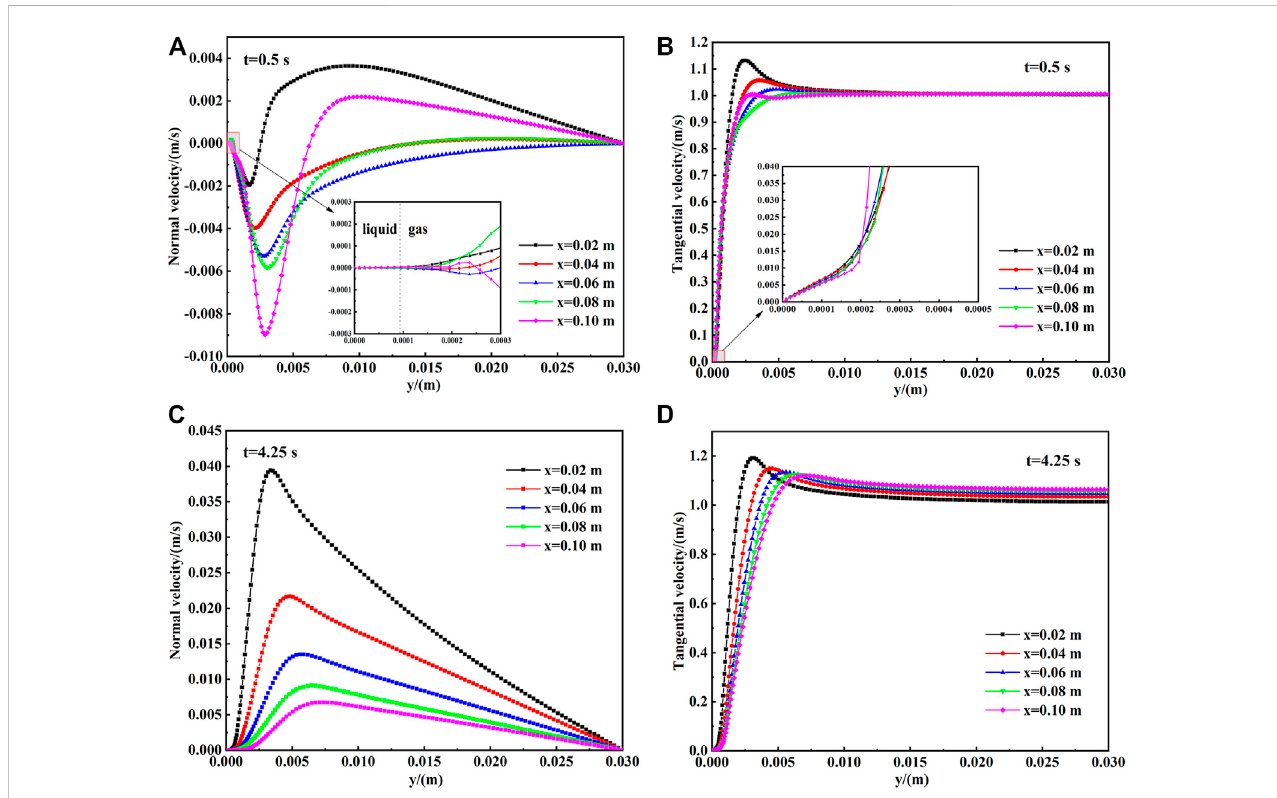
FIGURE 9 Velocity distributions in different positions on the wall in Case 2: (A) normal velocity at 0.5 s; (B) tangential velocity at 0.5 s; (C) normal velocity at 4.25 s; (D) tangential velocity at 4.25 s.